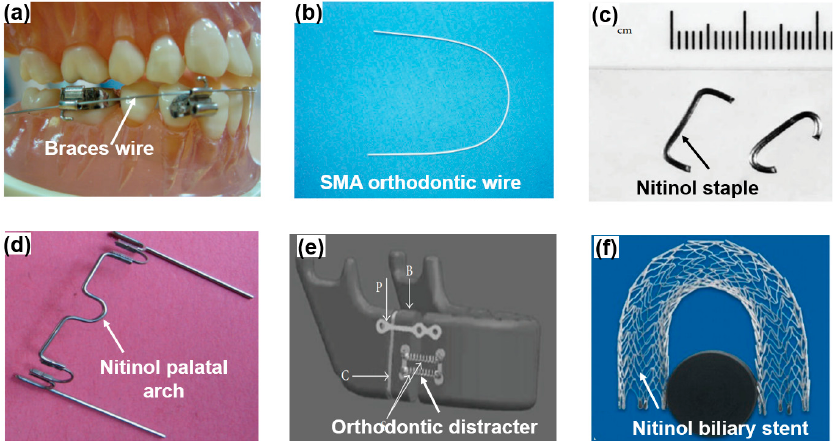
Figure 4. Actual applications of Ni-Ti wire used in previous work: ( a ) Braces wire; ( b ) SMA ortho- dontic wire; ( c ) Nitinol staple; ( d ) Nitinol palatal arch; ( e ) Orthodontic distracter; ( f ) Nitinol biliary stent. Data were obtained from Petrini et al. [19], CC-BY 4.0, and Song et al. [20], CC BY 3.0.